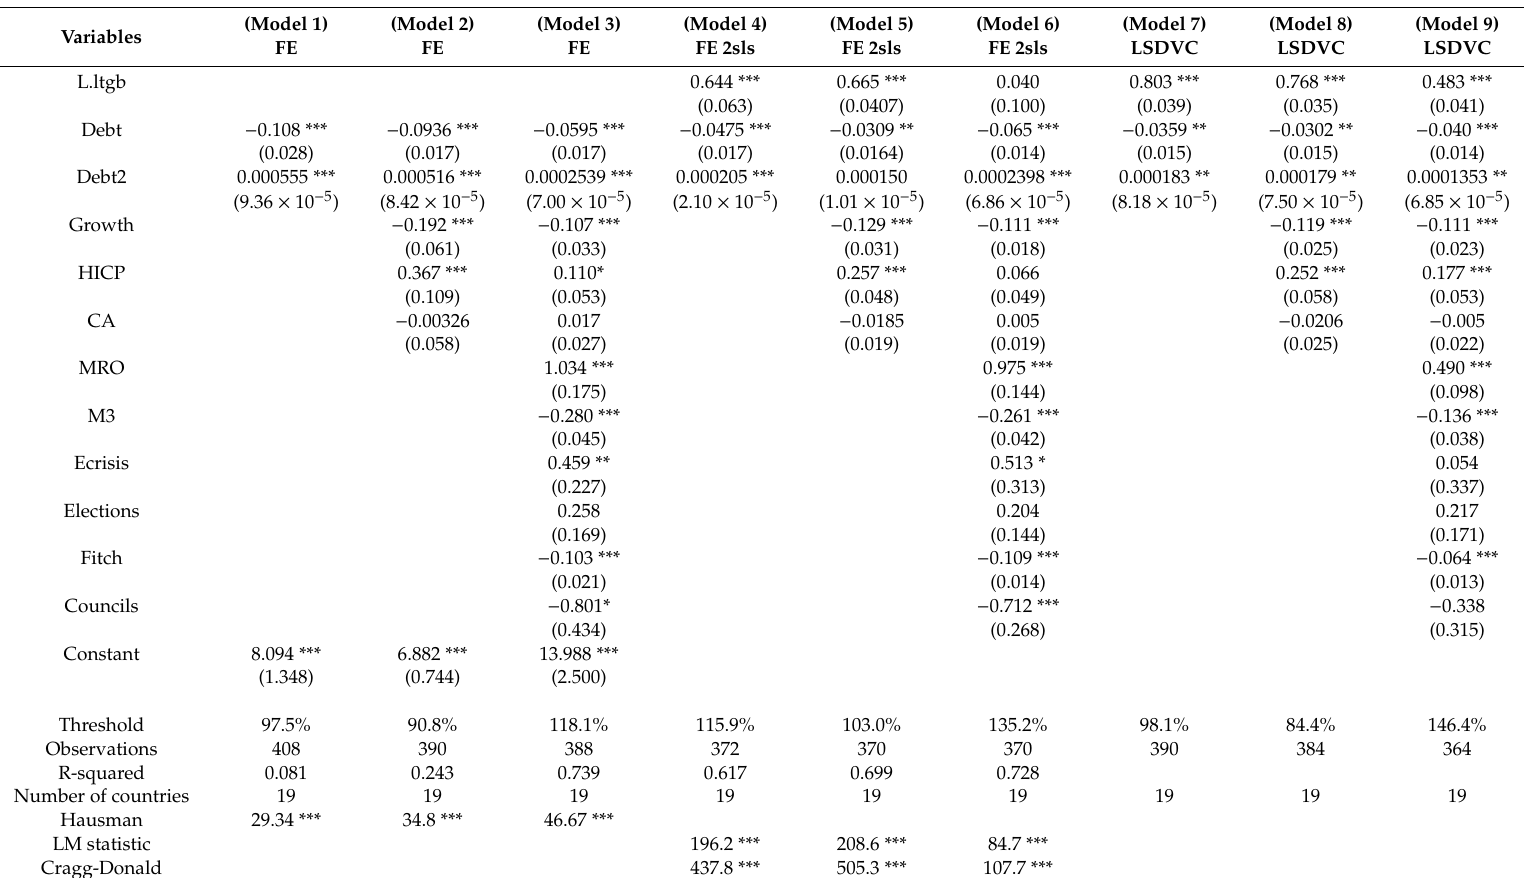
Table 2. Empirical results based on fixed e ff ects (FE), fixed e ff ects two-stage least squares (FE 2sls) and Least Square Dummy Variable Corrected (LSDVC)